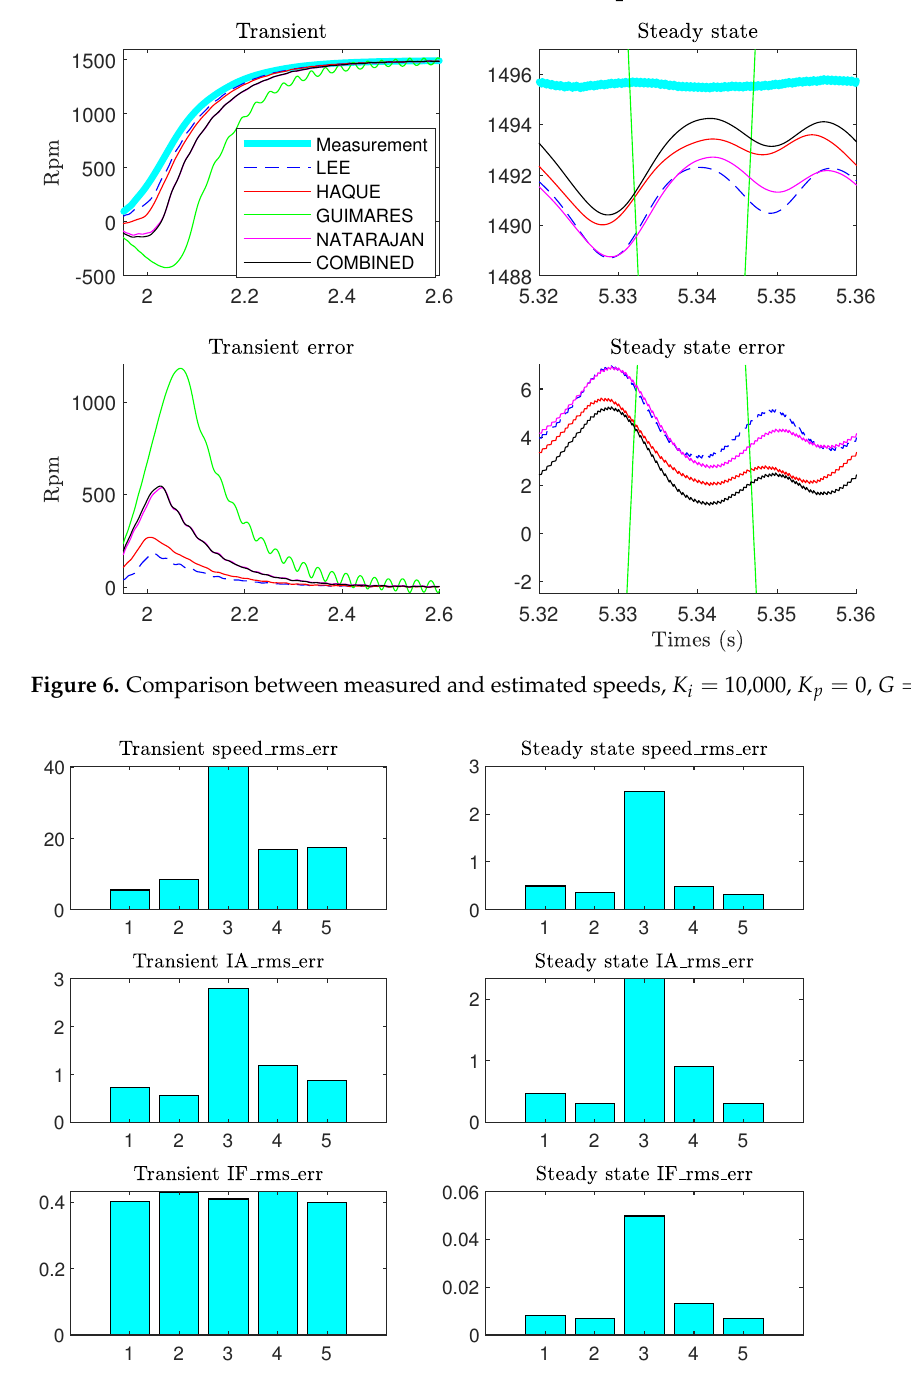
Figure 7. Criterion (15) calculated for speed, IA ( t ) and IF ( t ) : (1) Lee, (2) Haque, (3) Guimarães, (4) Natarajan, (5)